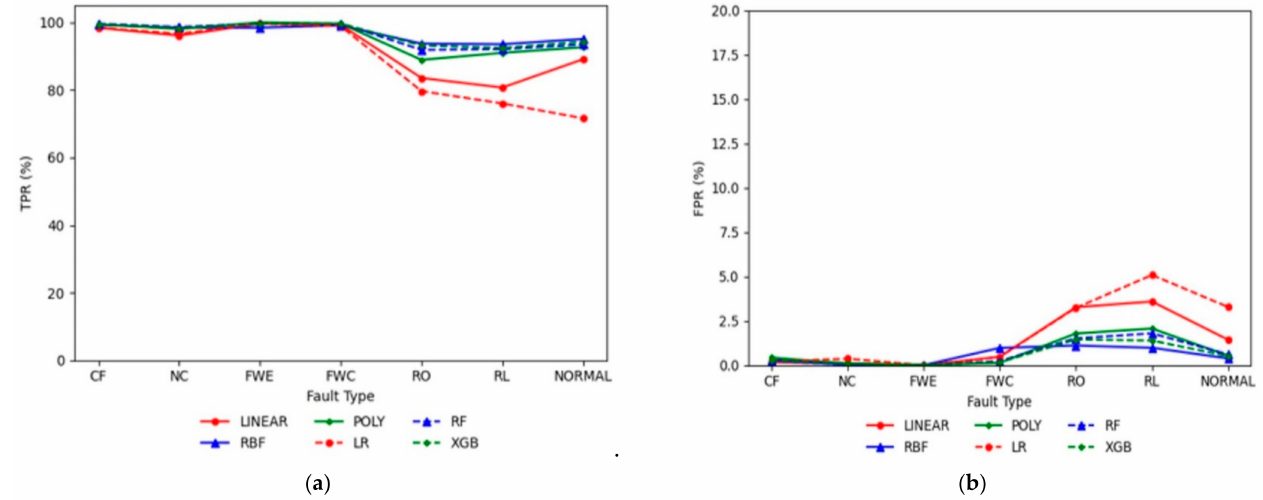
Figure 11. TPR and FPR values for each classification method (Case 2): ( a ) TPR; ( b ) FPR.